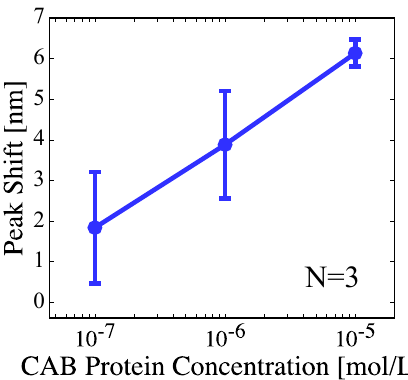
Figure 6. LSPR peak wavelength shift vs target CAB protein